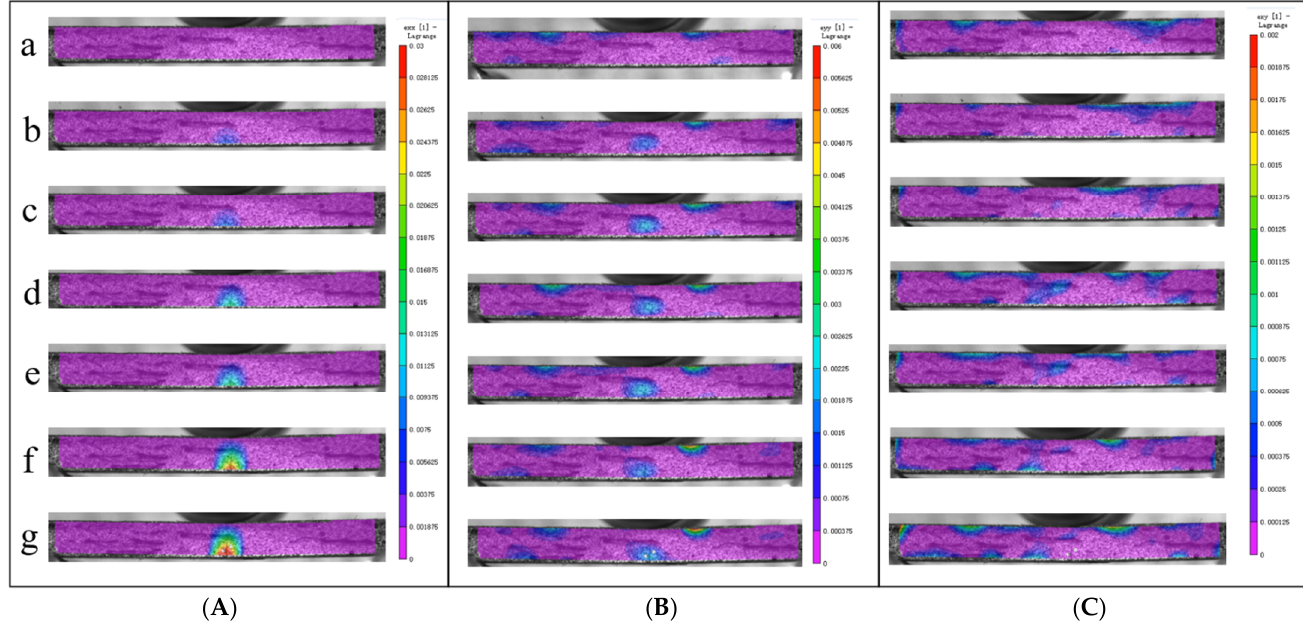
Figure 12. Evolutions of full-field strains under force of 180 N, 210 N, 165 N, 180 N, 145 N, 130 N, and 30 N ( A ) ε xx . ( B ) ε yy ( C ) ε xy